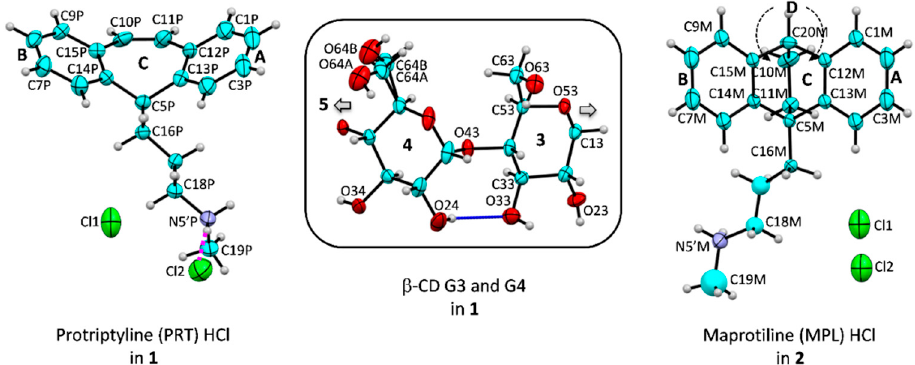
Figure 1. Atom numbering schemes of PRT HCl, MPL HCl, and β -CD (ORTEP plots at 20% probability level). In 1 and 2 , the protonated PRT-H + and MPL-H + at N5’ are charge-balanced by two half-occupied chlorides, of which their positions are arbitrarily shown here, except for PRT-H + that is directly coordinated by chloride Cl2 (magenta dotted line). The intramolecular, interglucose O3( n ) ··· O2( n + 1) hydrogen bonds stabilize the round β -CD conformation (connecting blue line). Note that the upward-facing obtuse butterfly angle has the (6-7/6-6)-tricyclic core lining with the B-C-A-rings from left to right, the -CH 2 –CH 2 - flexure, and the D-rings are beneath the C-ring for MPL.